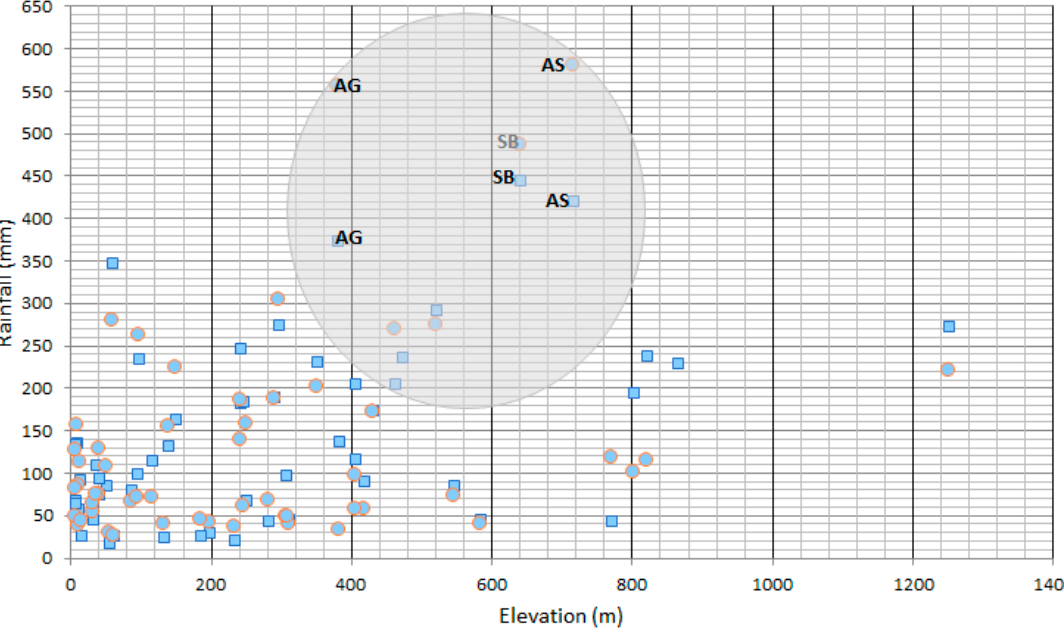
Figure 3. Accumulated rainfall (mm) versus elevation of the rain gauges (meters). Rectangles denote data during the first storm (Chioni) and circles during the second storm (Oceanis). The points corresponding to Askyfou, Asigonia, and Sebronas stations are labeled AS, AG, and SB, respectively (see Figure 1 for the locations of the stations).